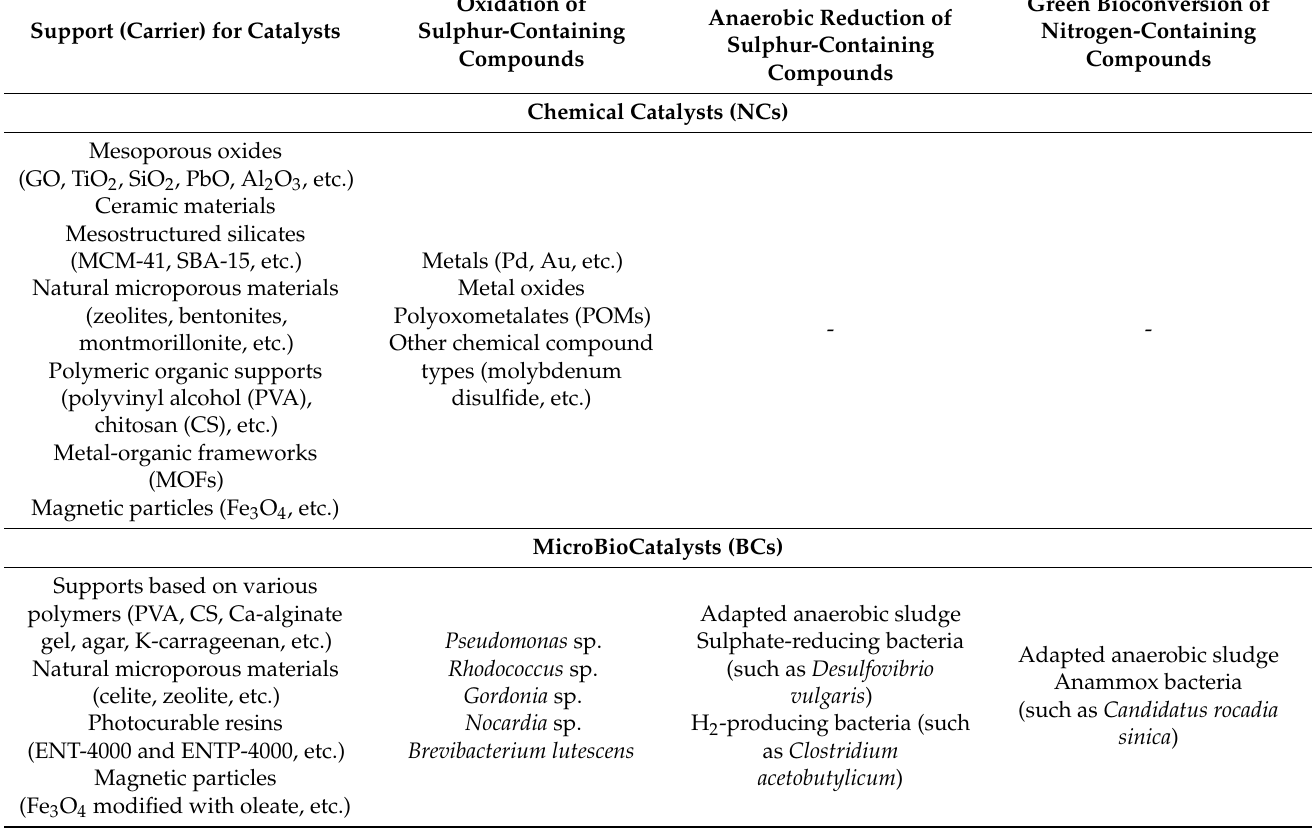
Table 3. Parts of hybrid chemical-biocatalytic desulphurization processes and components of heterogeneous catalysts. Support (Carrier) for Catalysts Mesoporous